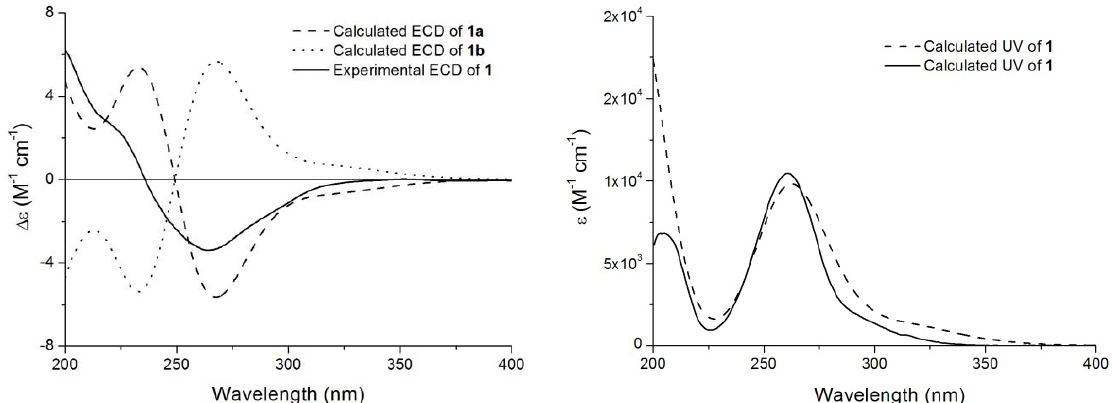
Figure 4. Comparison of theoretical and experimental ECD and UV spectra of compound 1